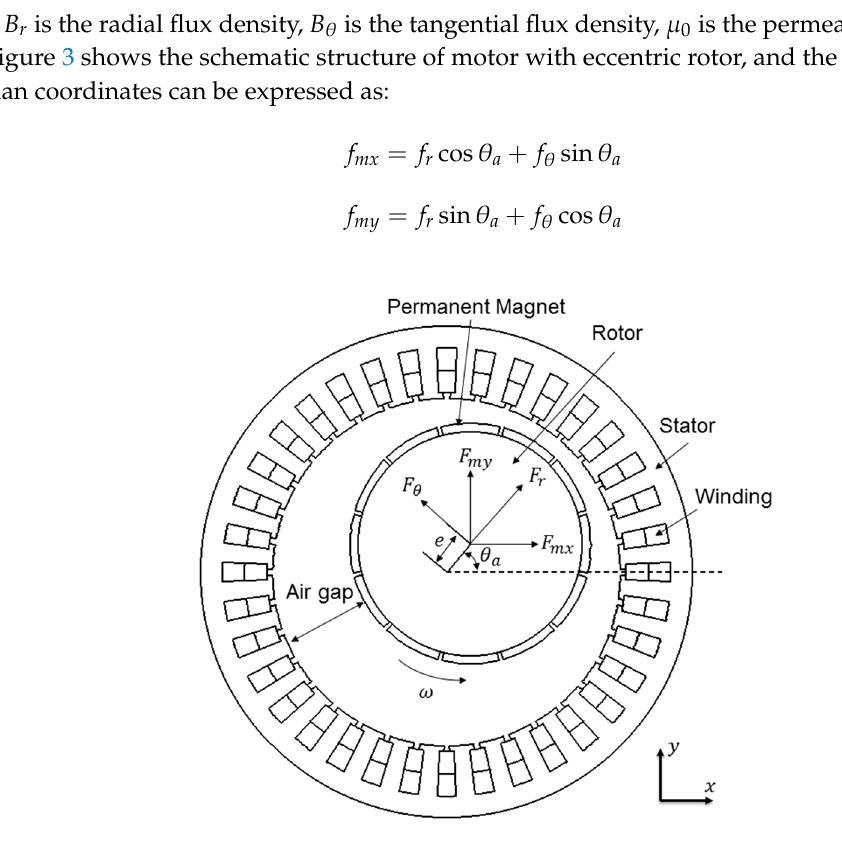
Figure 3. Schematic structure of the motor.